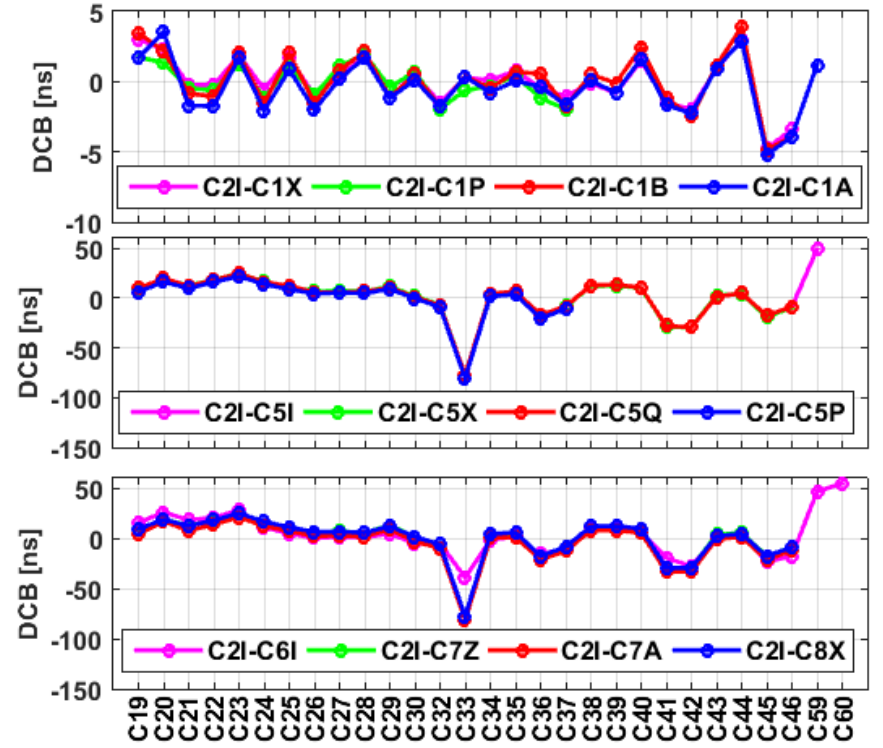
Figure 8. Mean values of BDS3-based DCBs during the period of DOY 214–244 in 2020. For evaluation of the stability of the BDS3 satellite-based DCBs, Figure 9 shows the monthly STDs of the BDS3 satellite-based DCB estimates of the signals among the different frequency bands. As shown in the figure, other than the C2I-C1A, C2I-C5Q, C2I-C5I and C2I-C7A DCB estimates, which exhibit large STDs, the STDs of the DCB estimates of the signal combinations are less than 0.2 ns. Similar to Figures 8 and 9, the mean values and STDs of the DCB estimates of each BDS2 satellite are shown in Figure 10. The BDS2 satellite-based DCB estimates are confined to a range of ± 20 ns. The monthly STDs of the BDS2 DCB estimates are mainly within 0.2 ns, showing better stability than those of the BDS3 satellites. In addition, because the signal quality of B3I is better than that of B2I [27], the stability of the C2I-C6I DCB estimates outperforms that of the C2I-C7I DCB